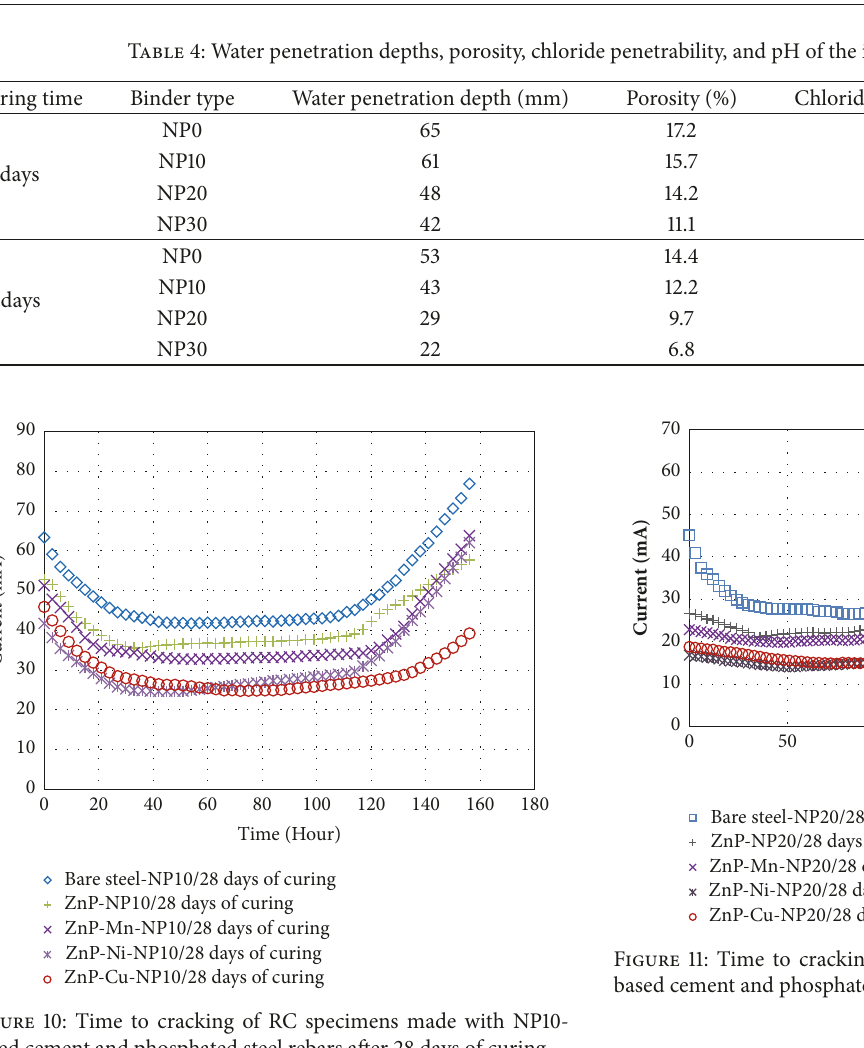
Figure 13. From the graphs, it is very clear to note that the time taken for initiation of 28-day cured concrete cracking was found to be 197, 215, 246, 263, and 232 h for bare steel rebar, ZnP coated steel rebar, ZnP-Mn coated steel rebar, ZnP-Ni coated steel rebar, and ZnP-Cu coated steel rebar which were embedded in NP30-based concrete, respectively. The